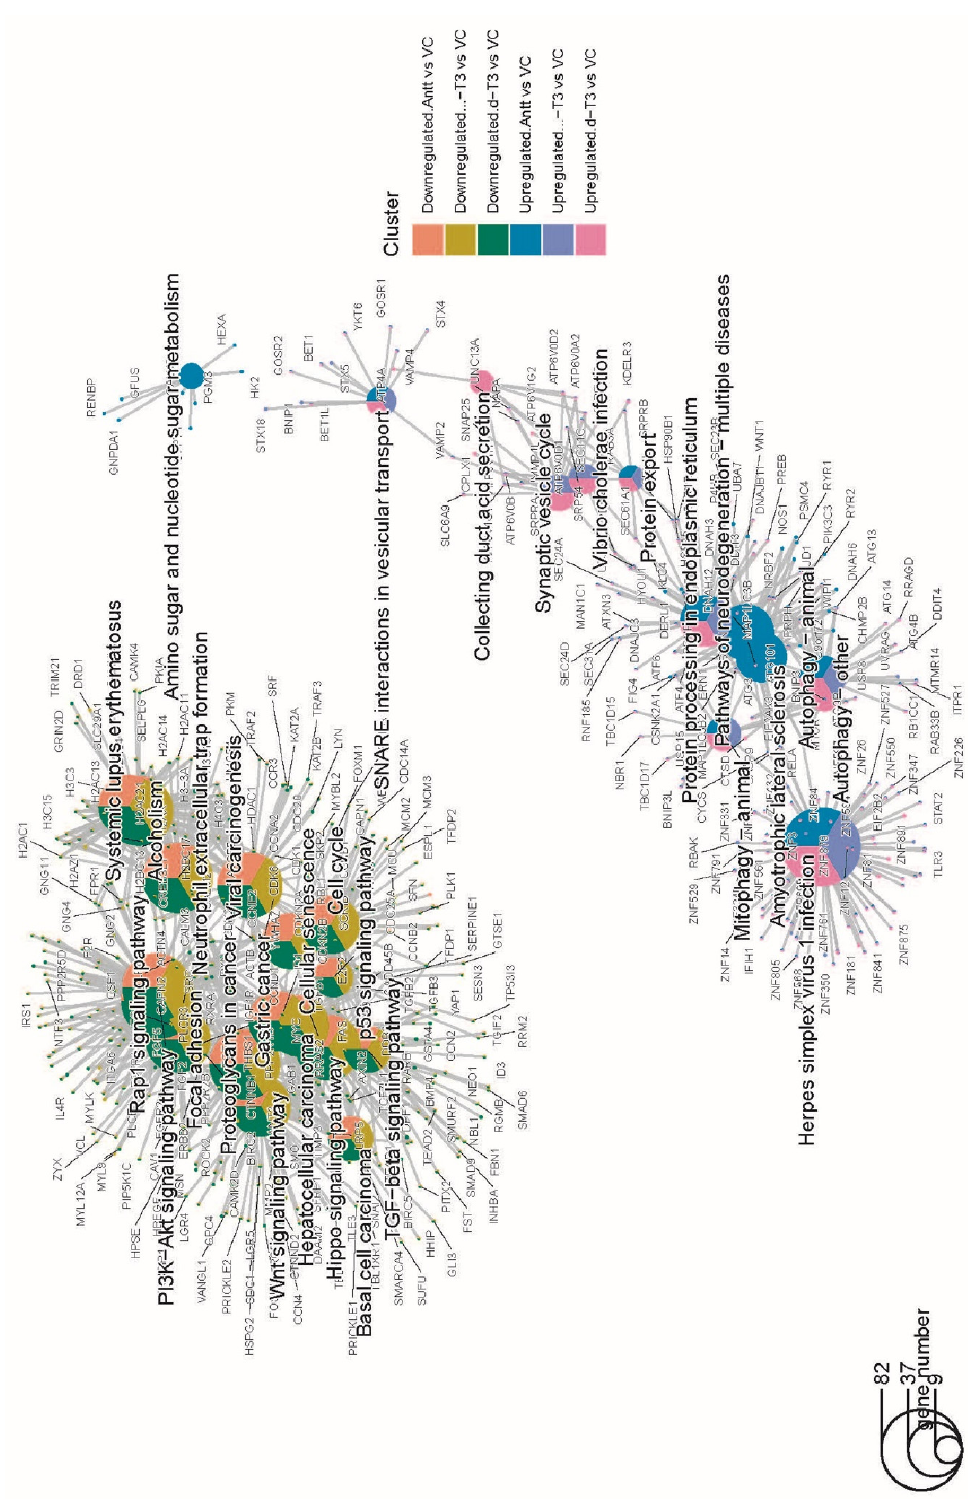
Figure 11. Cnetplot of KEGG pathways showing up- and down-regulated DEGs of tocotrienol treatments enriched in different pathways. The symbol adjacent to nodes represents the specific gene. The colour bar represents the up- or down-regulated DEG datasets for each treatment group.